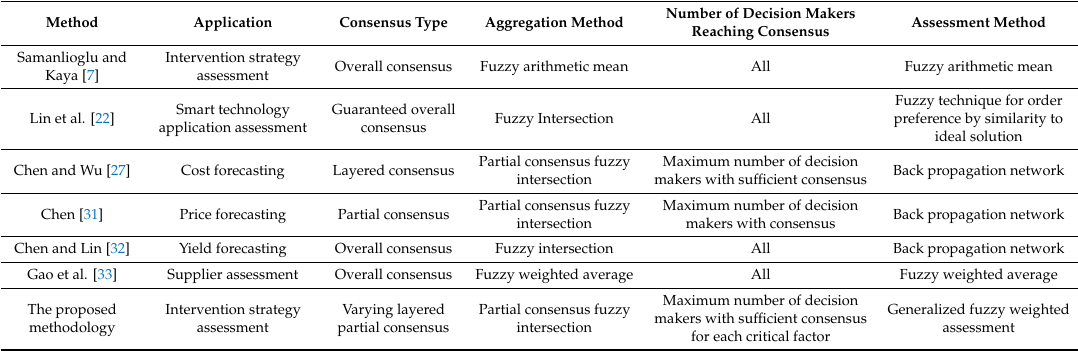
Table 1. Di ff erences between the proposed methodology and some existing